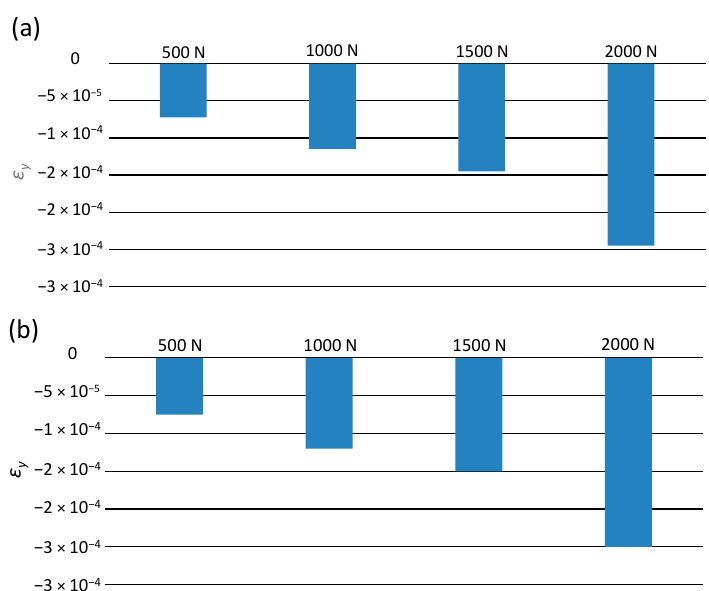
Figure 9. The maximum values of transverse deformations ε y : ( a ) on the upper surface of the pipes, ( b ) on the lower surface of the pipes.